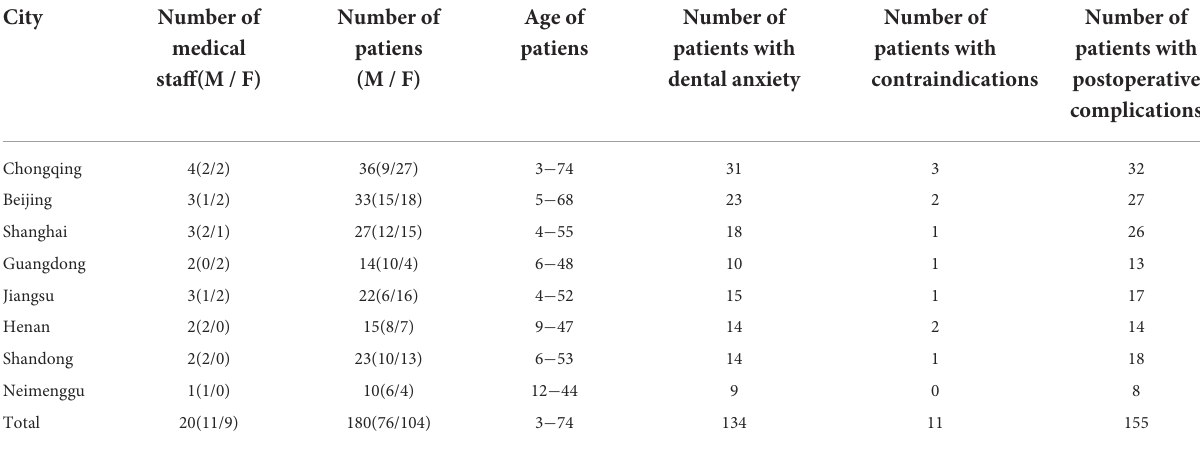
TABLE 1 Demographic data of